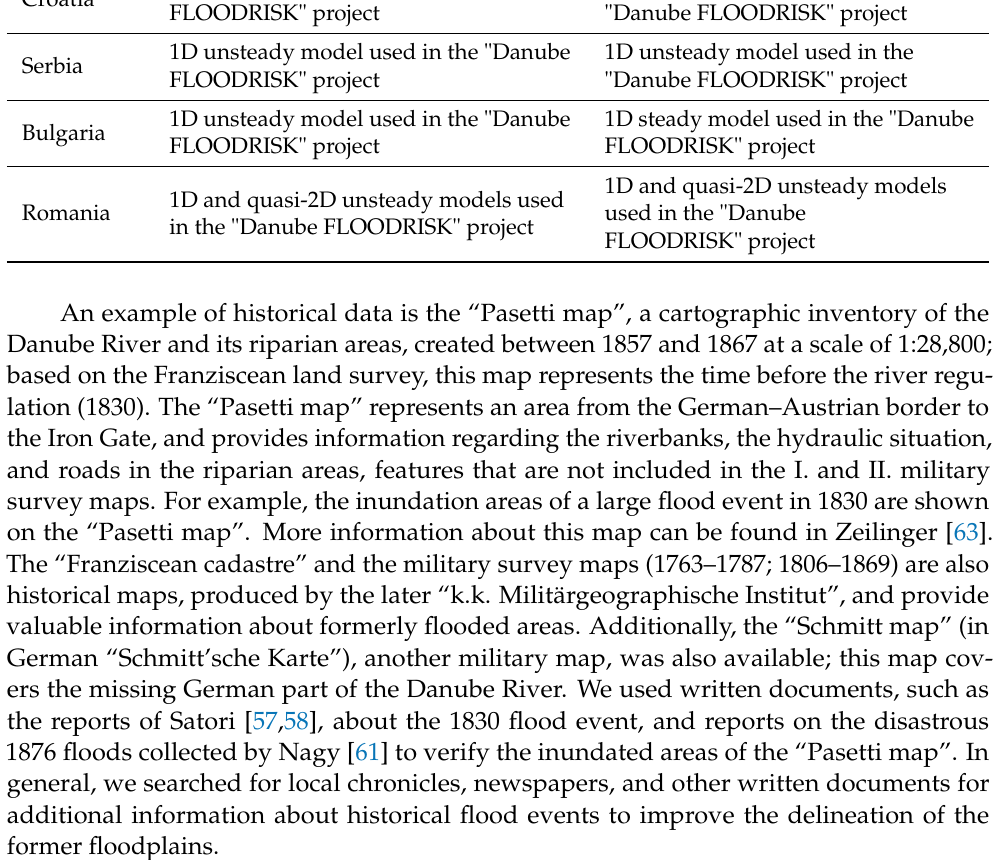
2D models used for latest national flood hazard maps 2D steady models used in the "Danube FLOODRISK" project